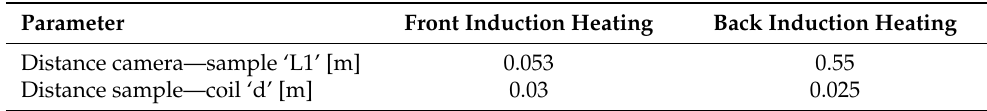
Table 4. Parameter values used during induction heating measurements for the inspection of spot welds. A visual representation of the parameters can be found in Figure 3.